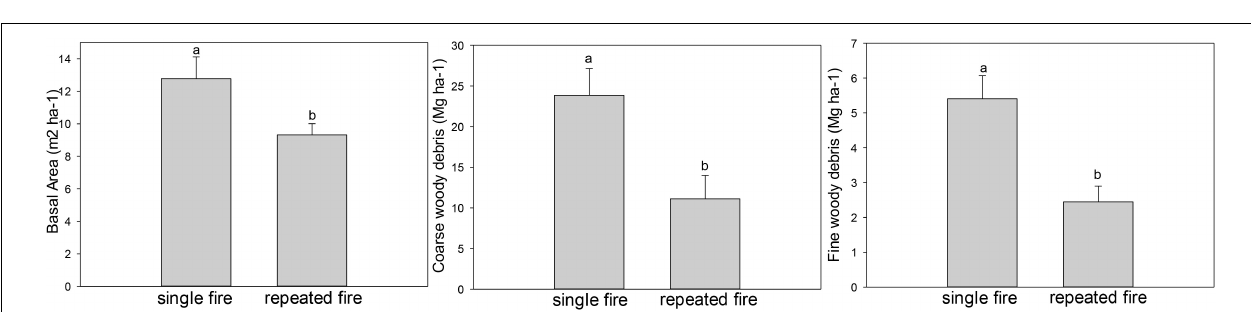
FIGURE 5 | Effect of a single wildfire compared to repeated wildfires measured 7 years following the most recent fire on tree basal area (includes both live and dead trees), coarse woody debris, and fine woody debris. Letters indicate significant differences at the α = 0.05